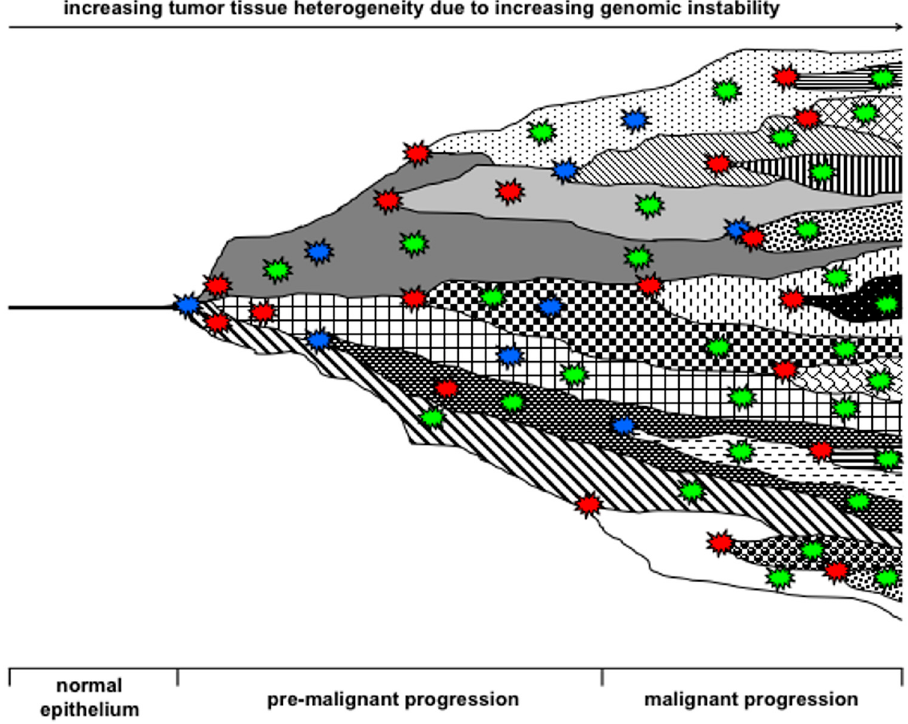
Figure 3. Model for tumor evolution and tumor tissue heterogeneity. In accordance with Figure 3, and to the interactive interplay of cell fusion, mutation and aneuploidy in causing a mutator phenotype the events were synonymously displayed as stars. Blue stars indicate mutator events, red stars indicate driver events and green stars indicate passenger events. The heterogeneity of the tumor tissue concomitant with the event increases in dependence of time and tumor progression, which also accounts for the number of mutator, driver and passenger events. Adapted from [64]. Cell fusion, mutation and aneuploidy are interacting with each other and are the real co-conspirators for induction of a mutator phenotype in cancer cells.